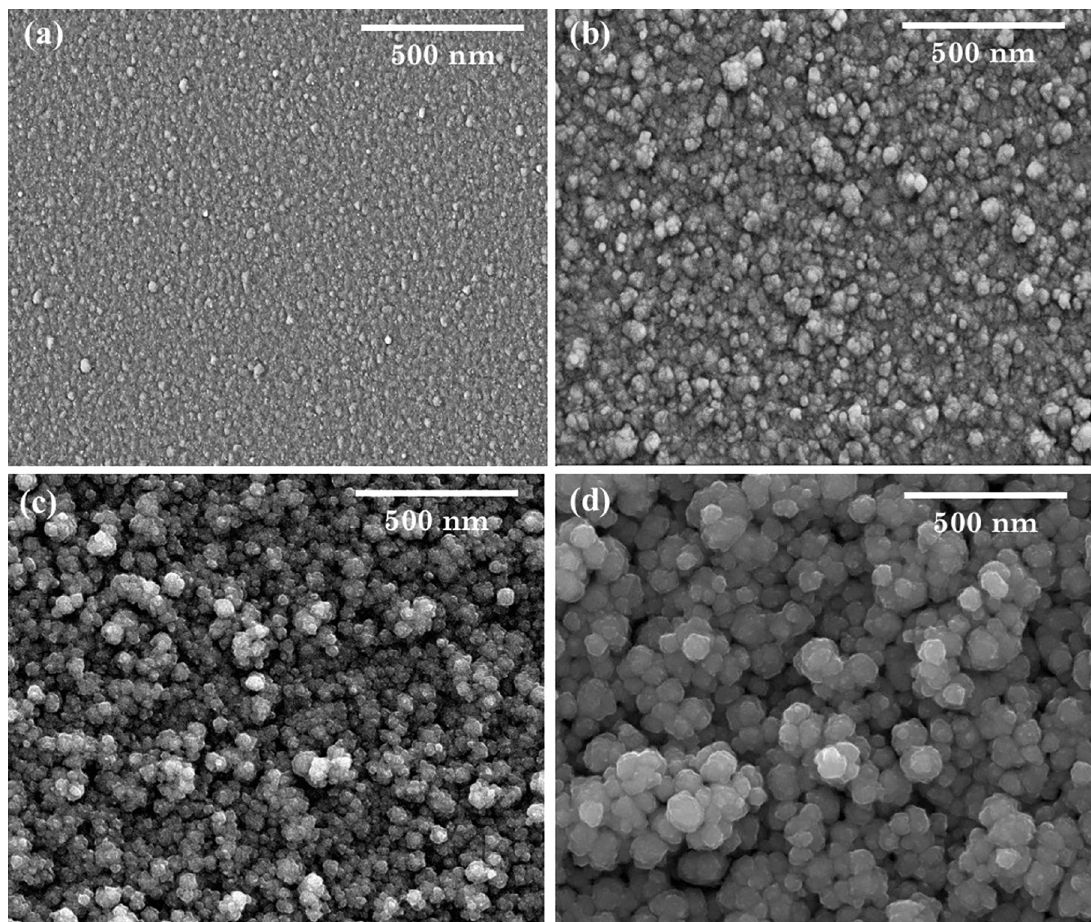
Figure 2. SEM images of (a) t = 30 nm, (b) t = 90 nm, (c) t = 150 nm and (d) t = 220 nm CrN/Si (100) films. temperature from 284 K to 400 K, the ρ decreasing